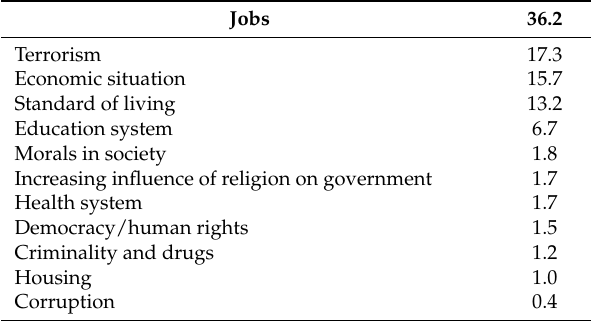
Table 9. Percentages saying that the most important problem facing the country